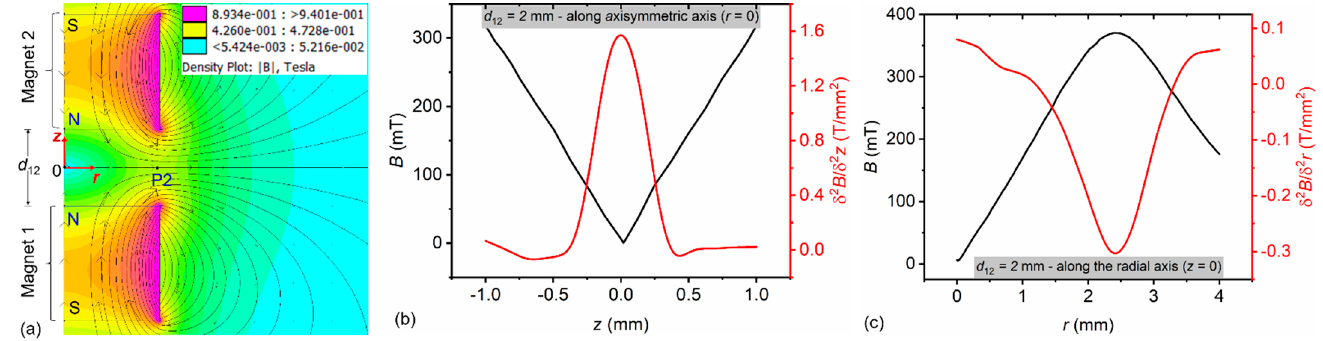
Figure 4. ( a ) FEMM simulation contour plot of the magnetic field distribution of two identical repelling permanent disk magnets (with radius r m ≈ 2.5 mm and length l m ≈ 3 mm). The axisymmetric (central) axis of each magnet was along its length l m —through the z -axis of the FEMM coordinate system. The magnetic fields also distributed radially outwards (along the radial axis r ). The origin of the coordinate system was at point zero “0”, and it corresponded to the position of near-zero field. ( b , c ) are the magnetic induction B (black line) and its second derivatives δ 2 B / δ z 2 and δ 2 B / δ r 2 (red line) as a function of the distance from the magnets’ pole face along the symmetric axis and the radial axis, respectively. The identical magnets used here were 2 mm apart.